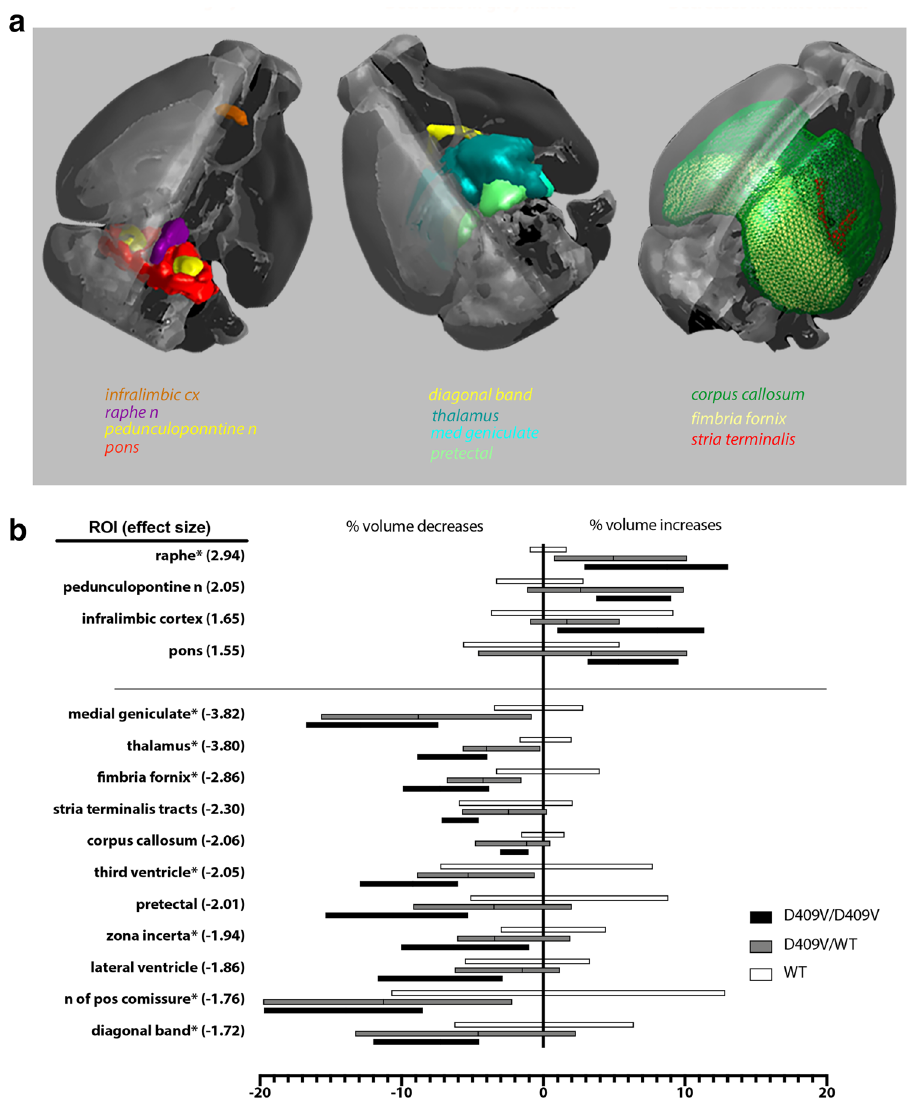
Figure 2. GBA1 Genotype-Driven Neuroanatomical Phenotypes. ROIs ( a , b ) with significant differences ( P < .05, FDR corrected) in volume, expressed as % of the averaged wildtype group. Note relative volumes decrease with genotype (WT > D409/WT > D409/D409), except in the dorsal raphe nucleus, pedunculopontine nuclei and infralimbic cortices where there is an opposite trend (WT < D409/WT <